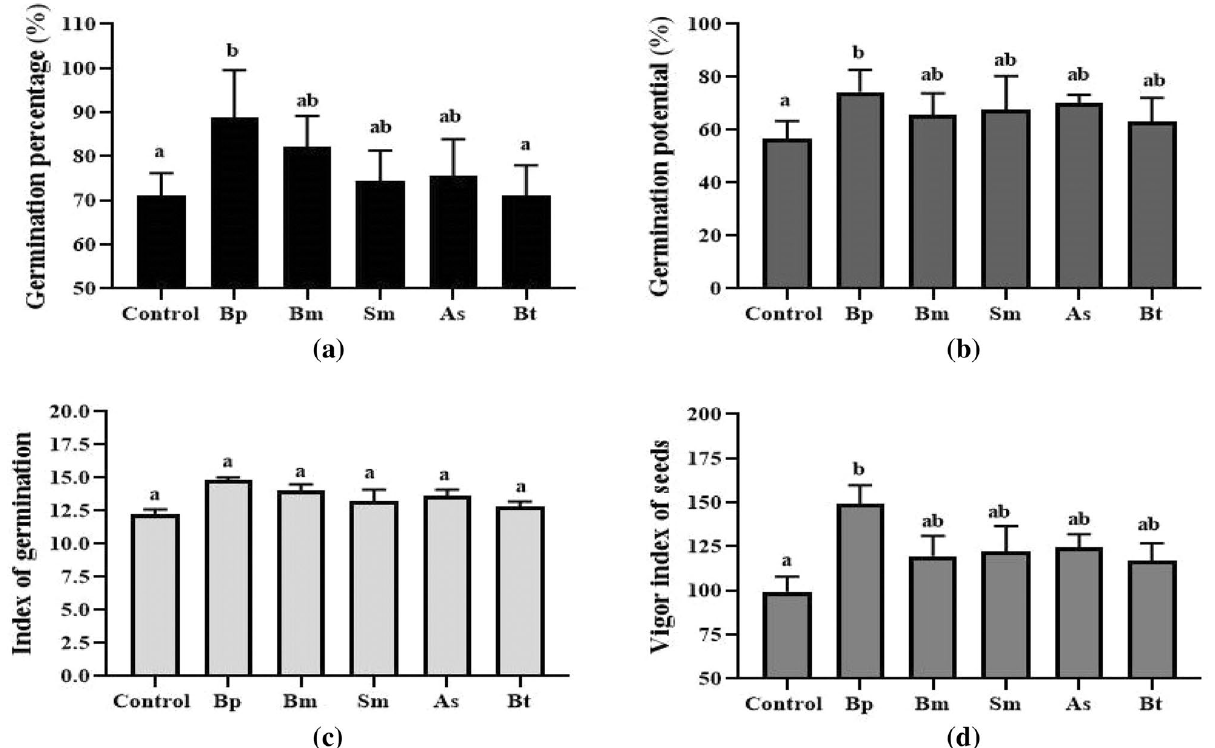
Figure 1. Germination parameters of wheat with five different bacterial inoculations. Here, ( a ); indicates germination rate, ( b ); indicates germination potential, ( c ); indicates germination index, and ( d ); indicates vigor index of seeds. Different letters indicate significant differences between mean ± SD of replications (n = 3) at a P < 0.05 significance